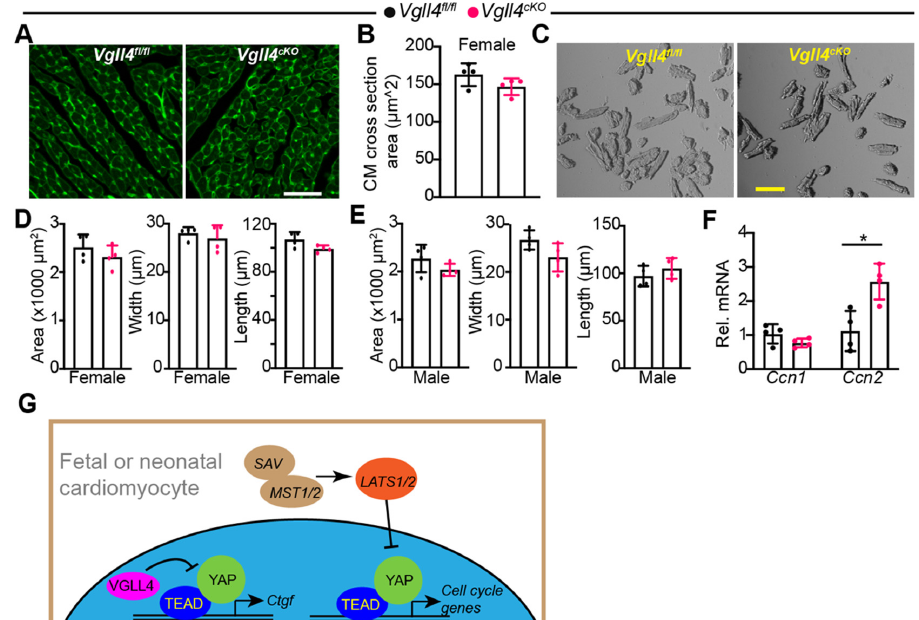
Figure 7. CM-specific depletion of VGLL4 does not affect CM size: ( A ) wheat germ agglutinin (WGA)-stained myocardium. Scale bar = 50 µm; ( B ) CM cross-sectional area. In each heart, 100–150 CMs were measured, and their average values are presented. A and B, heart sections from female mice were used. For each group, n = 4; ( C ) bright-field images of isolated CMs. Scale bar = 100 µm; ( D , E ) CM area, width, and length. Both female ( D ) and male ( E ) mice were included in this analysis. Average values of 150 isolated CMs from each dissociated heart are presented. For each group, n = 4; ( F ) qRT-PCR measurement of Ccn1 ( Cyr61 ) and Ccn2 ( Ctgf ). Total RNA extracted from isolated CMs was used for qRT-PCR. mRNA levels were normalized to Gapdh . Student’s t -test: * p < 0.05. N = 4; ( G ) diagram summary of the main findings of this study. Arrows indicate activation. Blunt-ended lines indicate suppression.